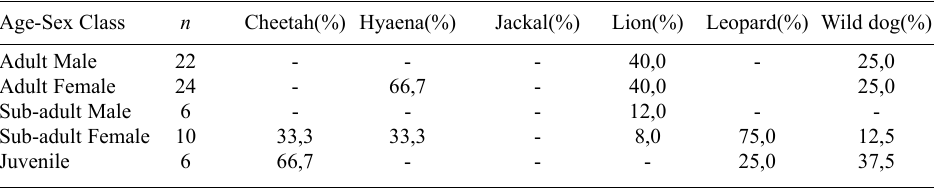
Proportional predation mortality of kudu Tragelaphus strepsiceros relative to each age and sex class Letaba Ranch, Limpopo Province